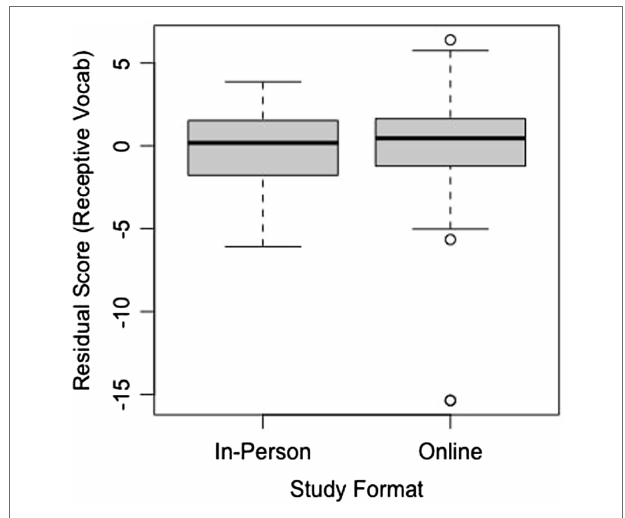
FIGURE 10 | Residual scores for both formats of receptive vocabulary section of the spatial language